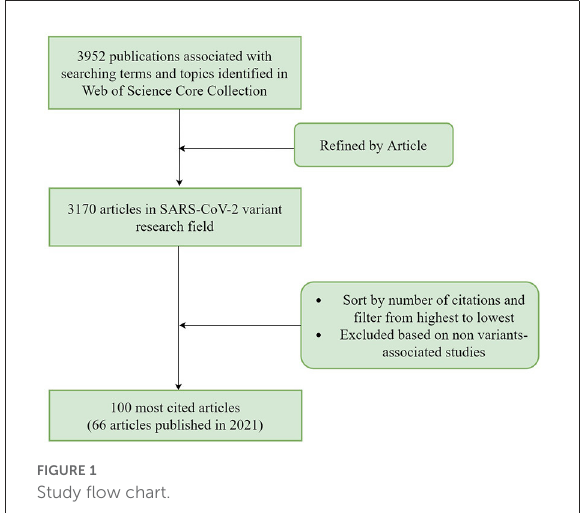
FIGURE1 Study flow